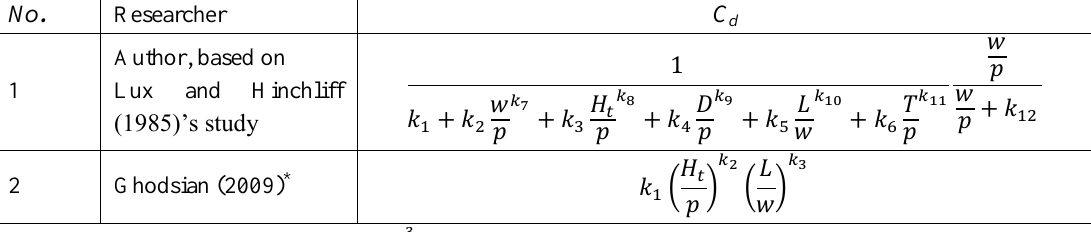
Table 1. Eequations for the calculation of the discharge flow rate of triangular labyrinth spillways